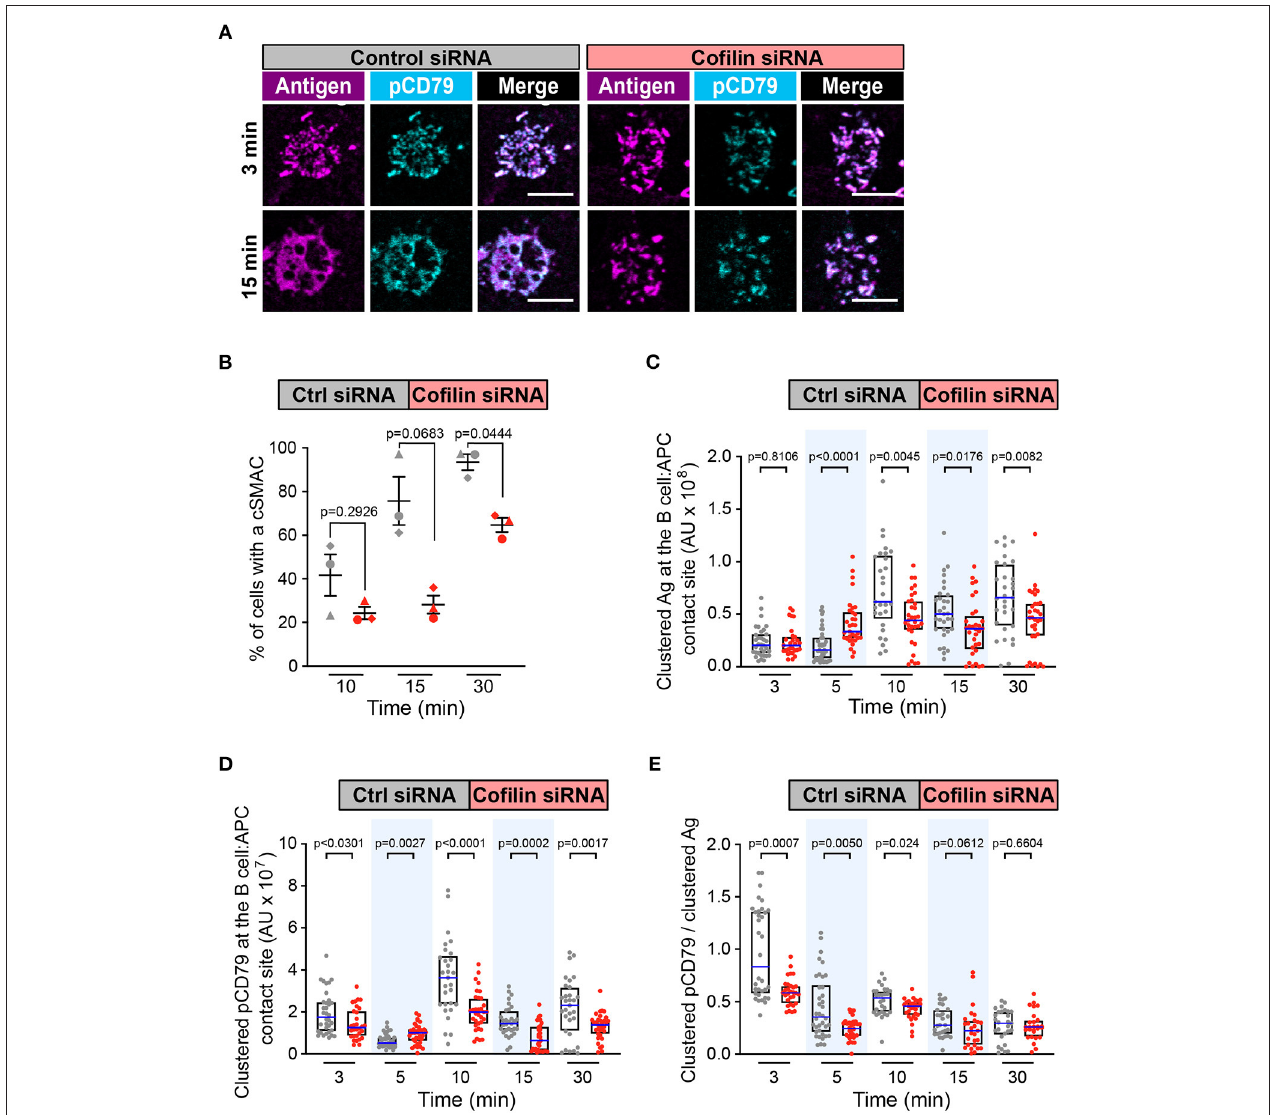
FIGURE 6 | Cofilin is important for cSMAC formation and BCR signaling at the immune synapse. A20 D1.3 B cells that had been transfected with control (Ctrl) siRNA or cofilin siRNA were added to mHEL-HaloTag-expressing COS-7 APCs. The cells were then fixed at the indicated times and the B cell-APC interface was imaged by spinning disk microscopy. (A) Representative images. Scale bars: 5 µ m. (B) For each time point, the percent of cells that had formed a cSMAC is graphed. Each symbol represents an independent experiment. Paired t -tests were used to calculate p-values. (C,D) The total fluorescence intensity of the mHEL-HaloTag Ag (C) or pCD79 (D) that was present in clusters at the B cell-APC contact site was quantified for each cell. Each dot is one cell. n > 30 cells per condition. The median (blue line) and interquartile ranges (black box) are shown. (E) For each B cell represented in (C,D) , the total fluorescence intensity of clustered pCD79 was divided by the total fluorescence intensity of clustered Ag. The median (blue line) and interquartile ranges (black box) are shown. The data in (C–E) are from the same experiment, which is representative of three independent experiments. The Mann-Whitney U test was used to calculate p-values for (C–E)